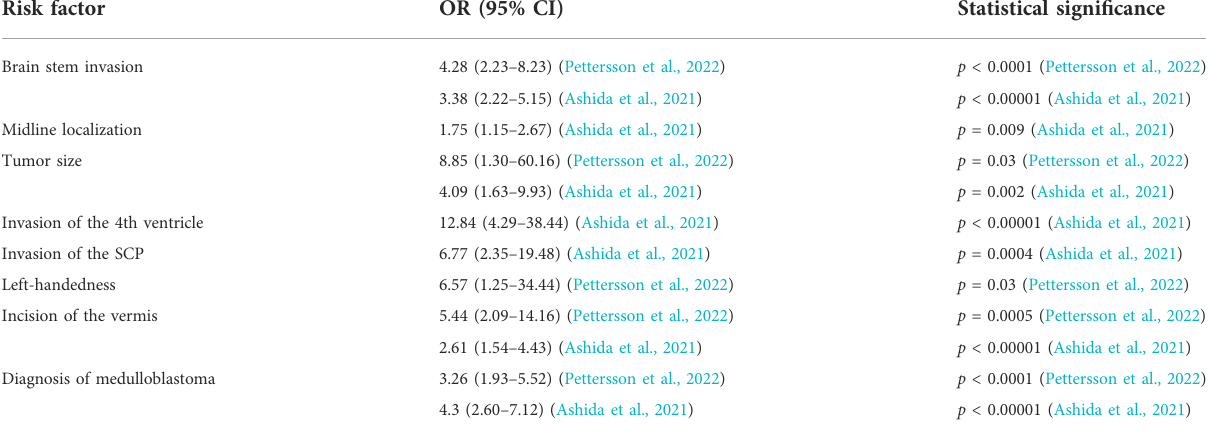
TABLE 1 Risk factors based on (Ashida et al., 2021; Pettersson et al., 2022) fi nding are